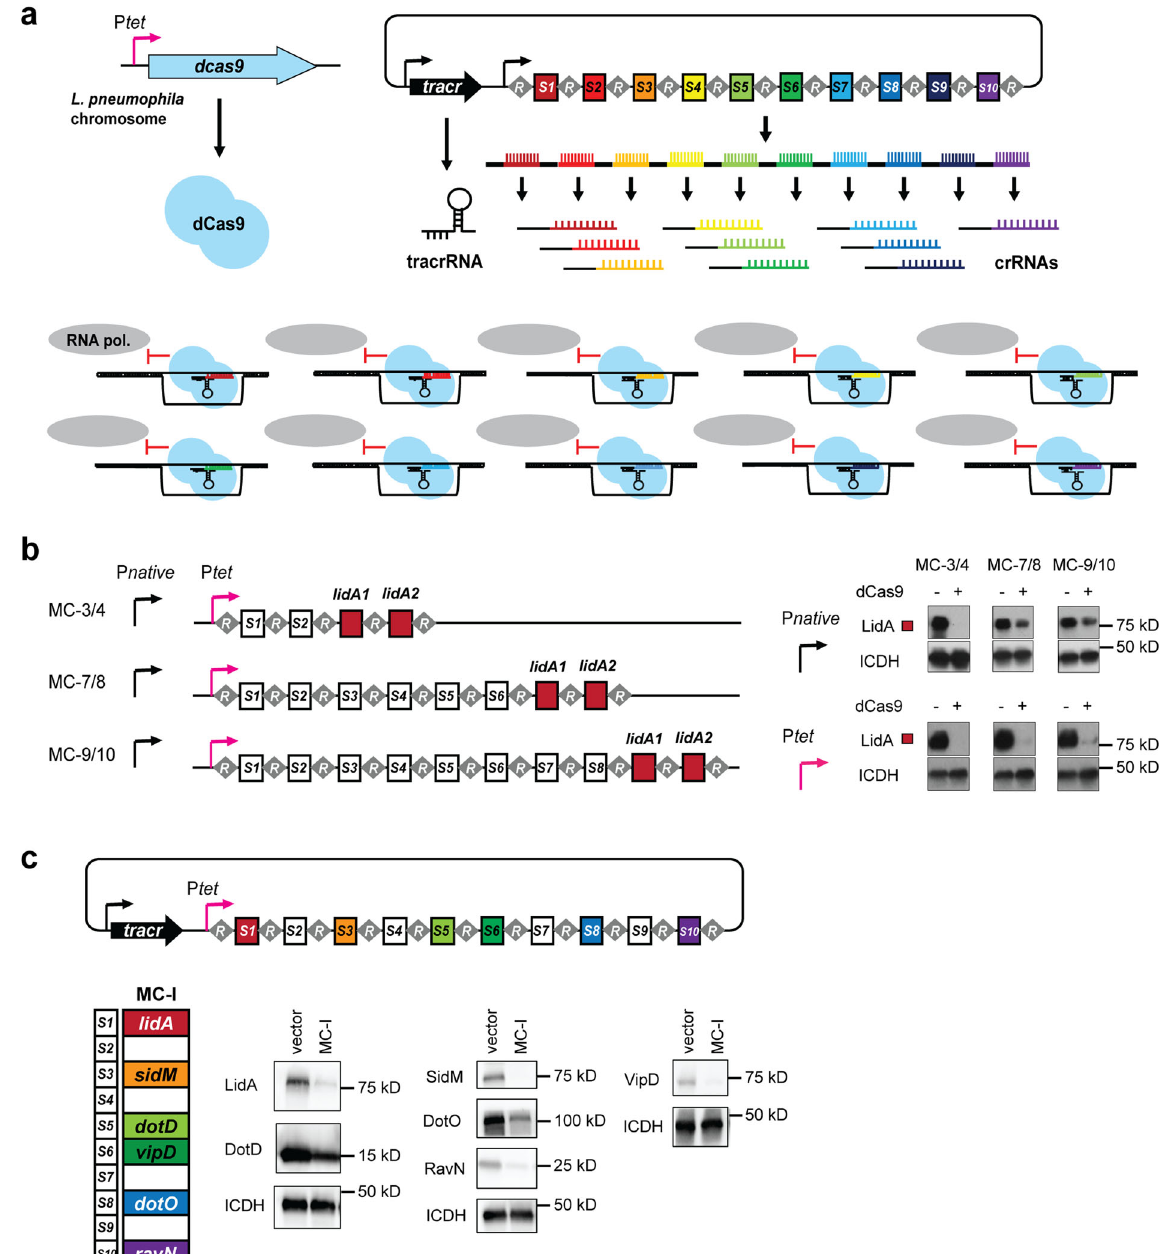
Fig. 2 Repeat/spacer arrays facilitate multiplex gene silencing. a Schematic representation of the theory of multiplex CRISPRi. A series of repeats, R, and spacers, S1 - S10 , are expressed as a single precursor-crRNA. Upon processing, individual crRNAs come together with a tracrRNA and dCas9 to simultaneously target ten unique genes for silencing. b Multiplex CRISPR (MC) repeat/spacer array constructs of increasing length were placed under the control of the native S. pyogenes promoter, P native , or P tet . Ef fi ciency of lidA targeting by crRNAs encoded by the terminal spacers of each array was assessed by monitoring LidA protein levels in Lp02( dcas9 ) and Lp02 by immunoblot. ICDH serves as a loading control. c A P tet - MC construct, MC-I, capable of expressing ten unique crRNAs was designed. crRNAs encoded by S1 , S3 , S5 , S6 , S8 , or S10 target genes in which antibodies directed against their encoded gene products are available. Bacteria pellets were collected from axenic cultures containing MC-I or the empty vector ( + 40 ng/mL aTC) and multiple immunoblots were run to accommodate the range of targets. ICDH serves as a loading control. Replicates are given in Supplementary Fig.